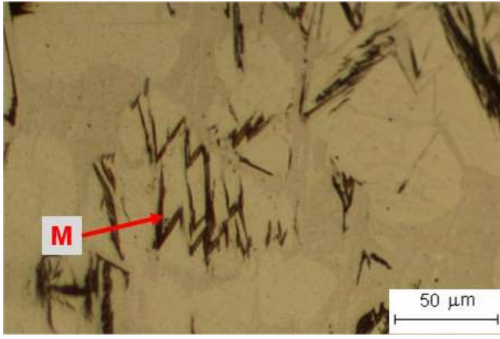
Figure 12. Vilella reagent for 20 s, (200 ×